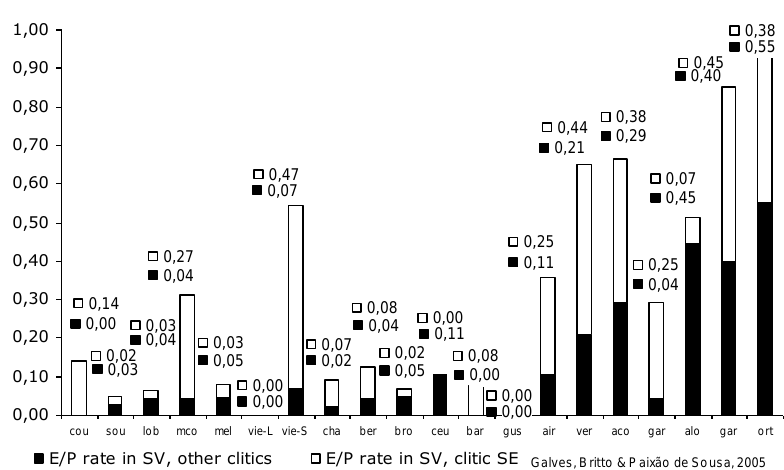
Figure 2b : Enclisis versus Proclisis with pre-verbal subjects – clitic SE and others